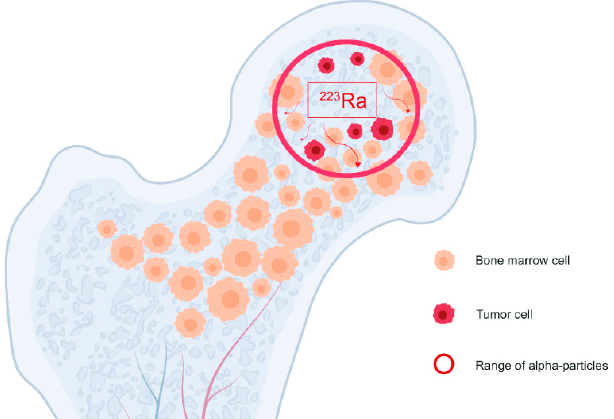
Figure 5. Local bone analgesic activity of alpha radiation delivered with Radium-223-dichloride.